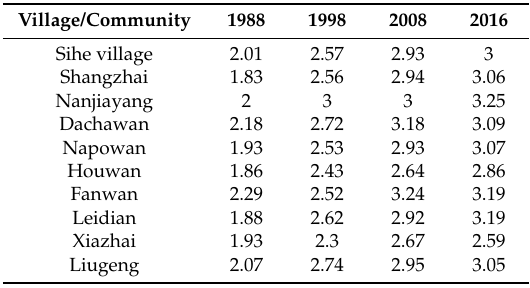
Table 6. Livelihood diversity indexes of Sihe village and communities from 1988 to